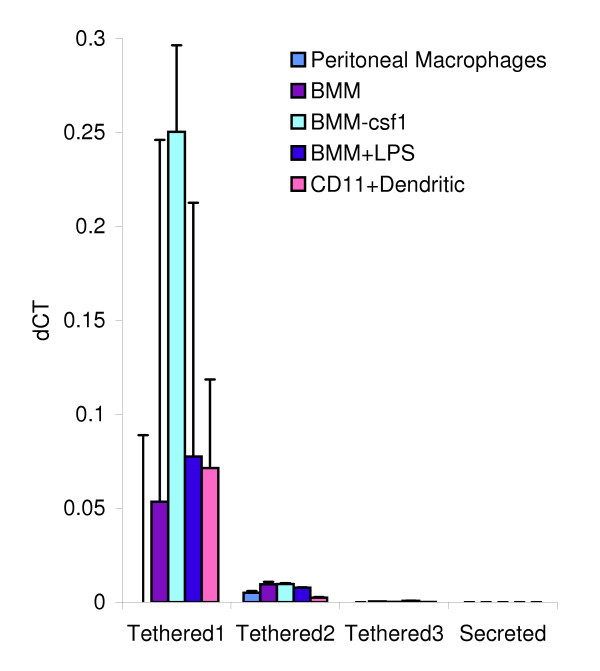
Expression of variant Csf1r transcripts relative to the full-length isoform. BMM, bone marrow derived macrophages; dCT, differences in cycle numbers between variant and full-length isoforms; LPS, lipopolysaccharide.